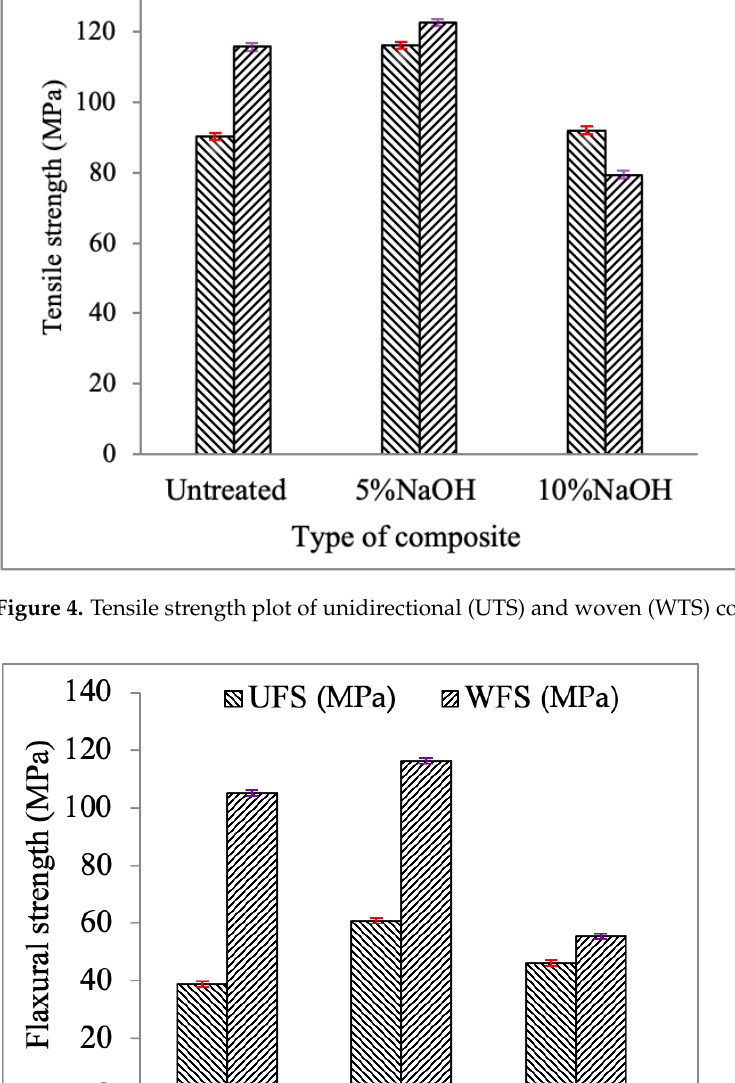
Figure 4. Tensile strength plot of unidirectional (UTS) and woven (WTS) composites.